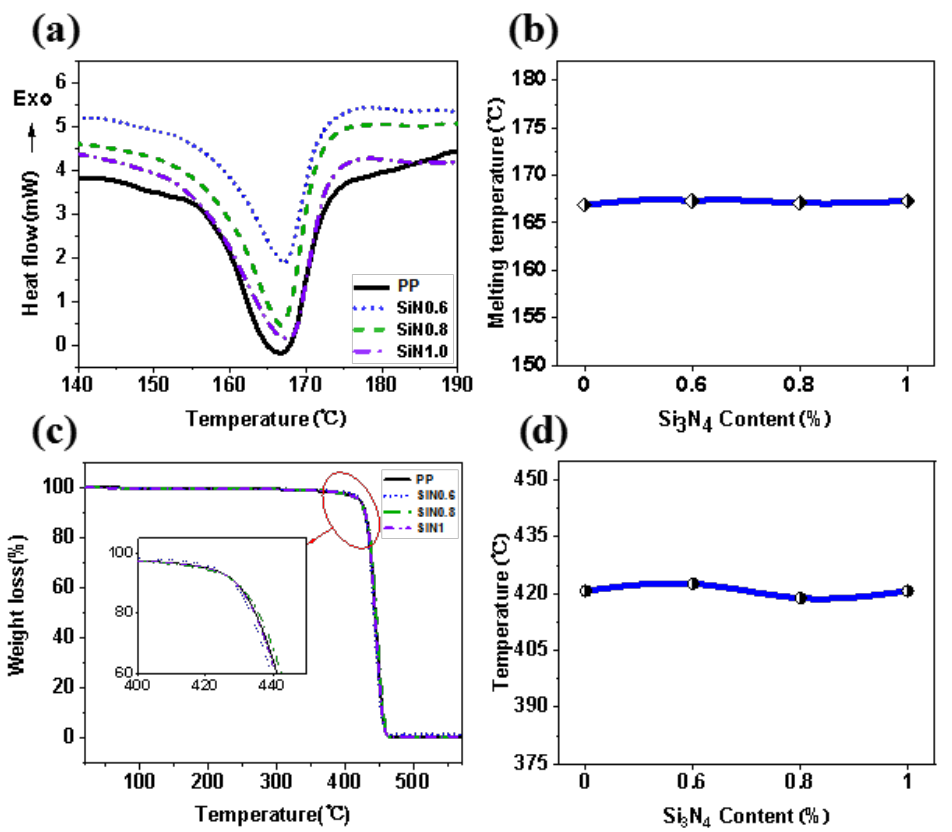
Figure 5. Thermal properties of PP with different Si 3 N 4 contents: ( a ) heat flow curve (DSC), ( b ) melting temperature, ( c ) thermal decomposition curve and ( d ) decomposition temperature.